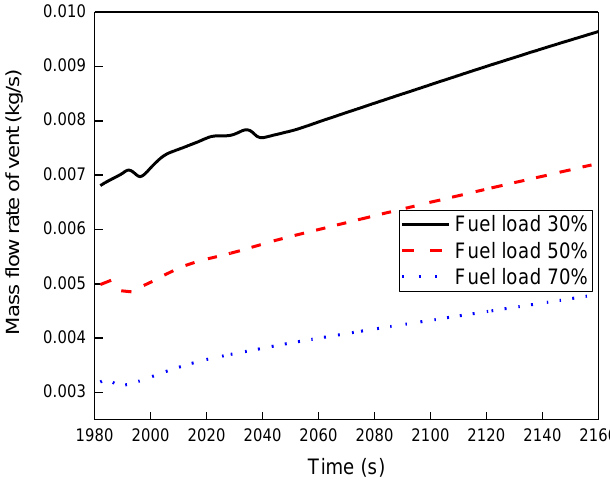
Figure 6. Air flow rate of vent during tactical descent.